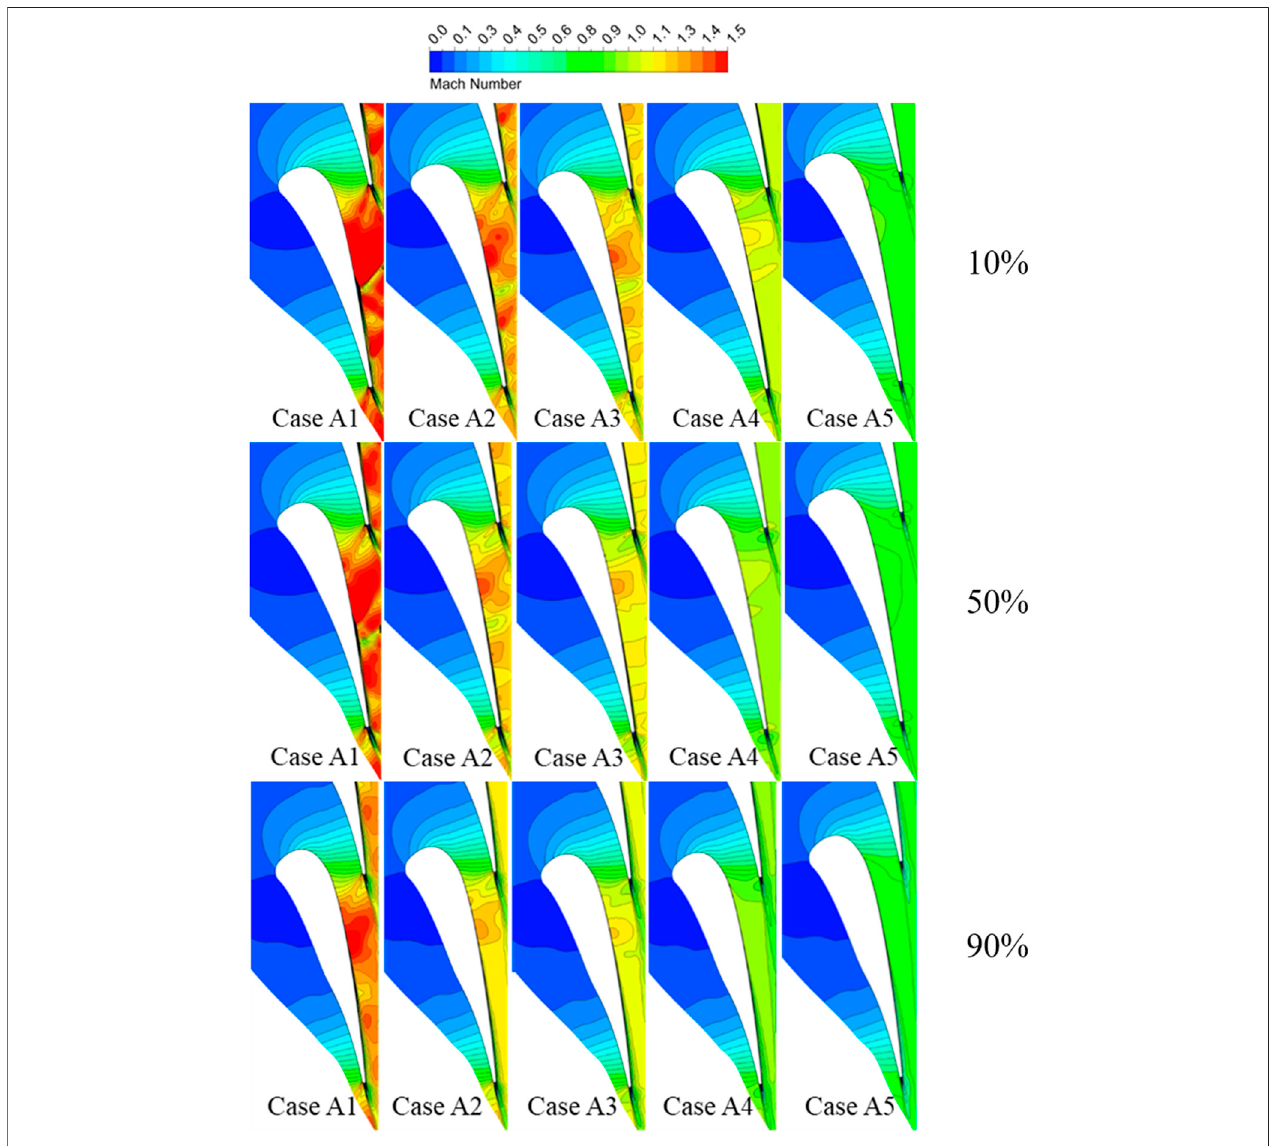
FIGURE 7 | Mach number distribution of stators from Case A1 to Case